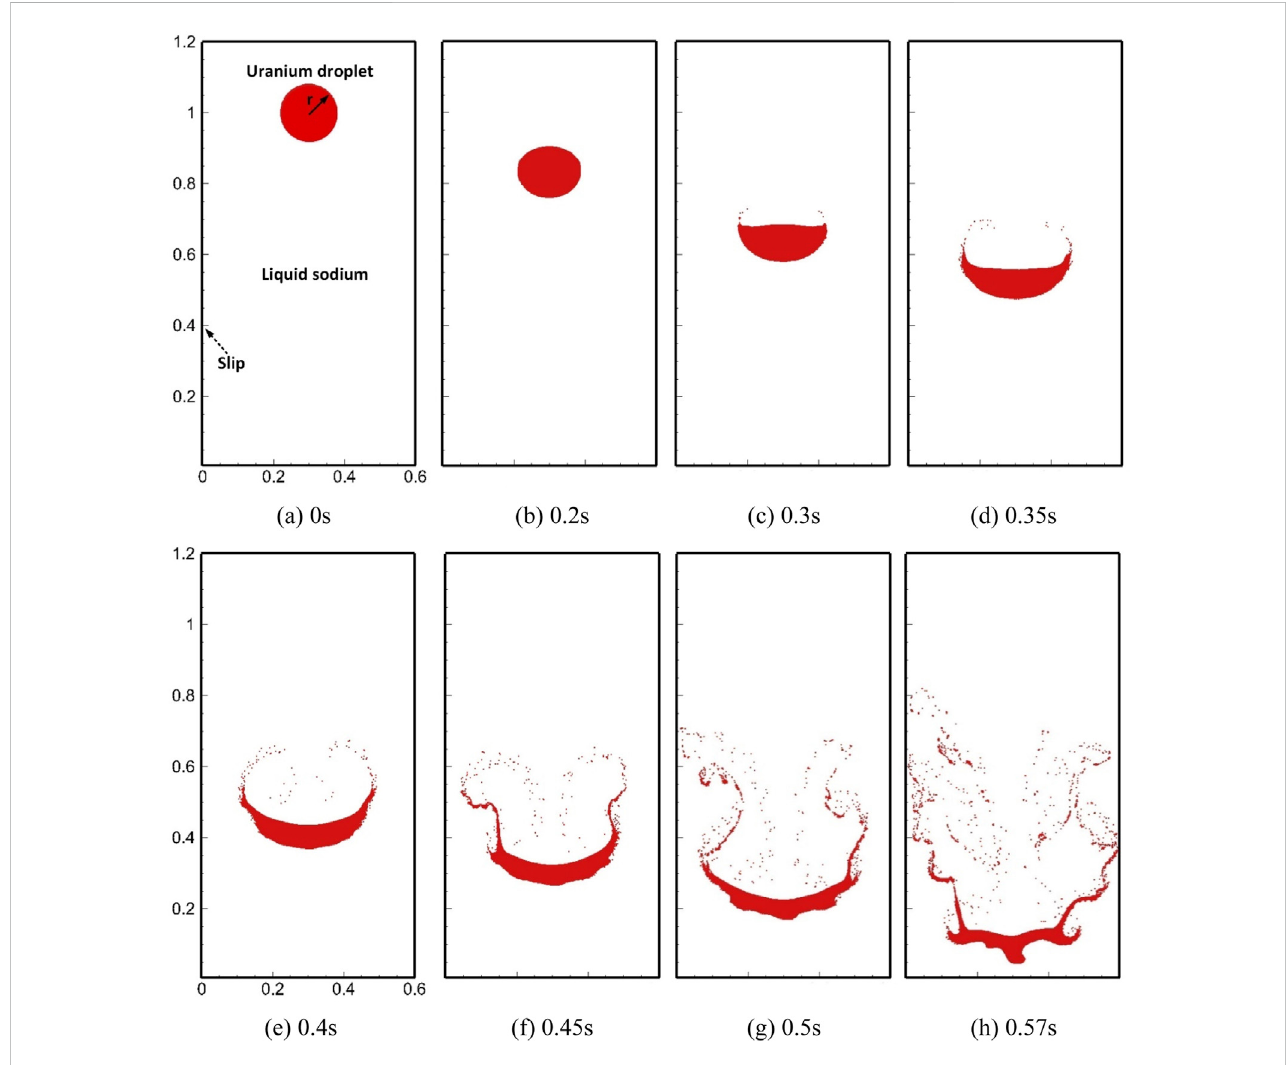
FIGURE 10 Initial setup and images in U-Na